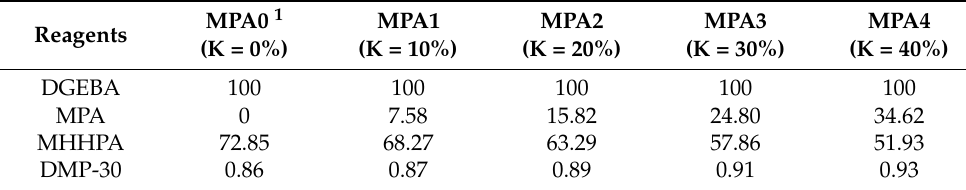
Table 2. The mass ratio of each component at different blending ratios.